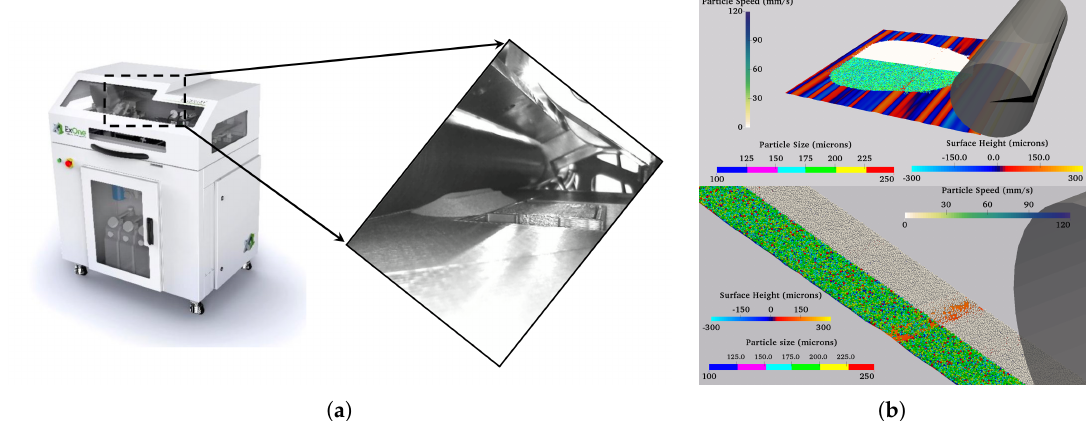
Figure 2. Synergy between experiments and physics-based modeling ( a ) A powder-bed 3D printer with inset showing single layer spreading experiment on an additively manufactured spreading substrate, refer [4] for details ( b ) Particle-Surface Tribology Analysis Code (P-STAC) simulation images—full view ( top ), zoomed-in view showing only a part of the spread layer with a visible spread layer defect of partial coverage ( bottom ).